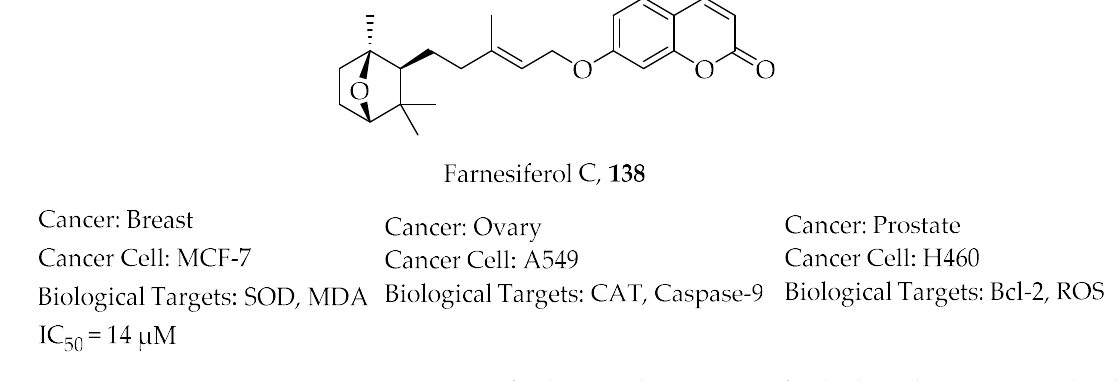
Figure 29. Structure a sesquiterpene coumarin Farnesiferol C with the summary of its biological activity towards selected cancer targets.